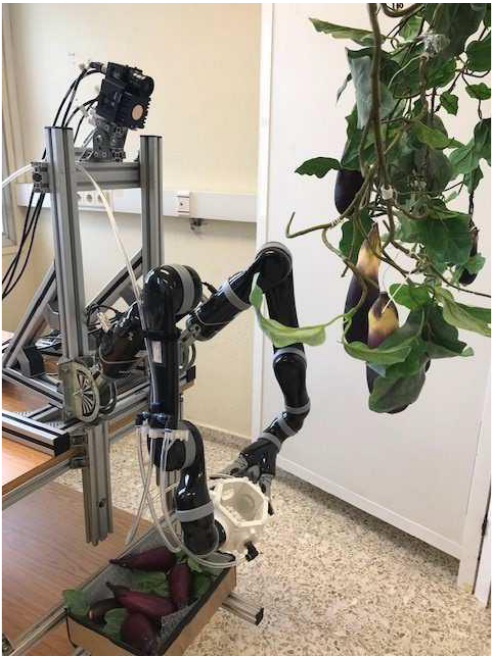
Figure 4. Soft gripper robotic arm designed in Spain for robotic agricultural harvesters [8].